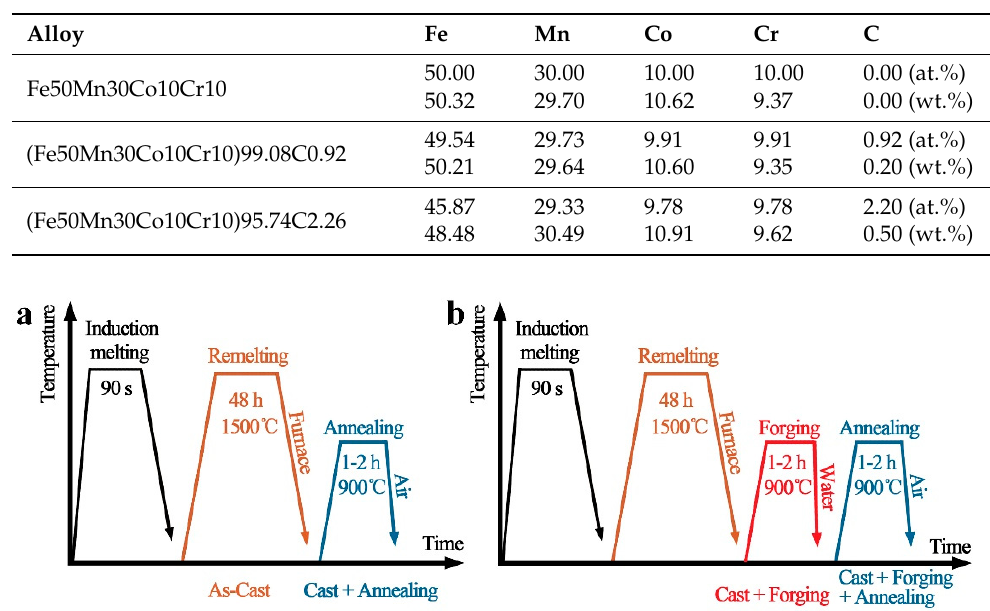
Table 2. Measured chemical compositions after melting (wt.%).